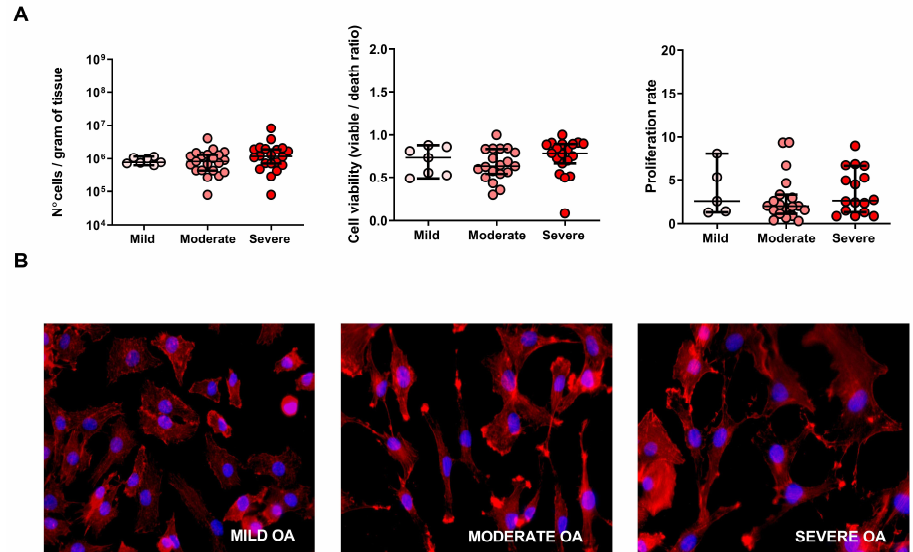
Figure 3. Cell number, viability and proliferation rate of cells derived from mild, moderate and severe OA regions. ( A ) The number of cells obtained from different OA grades after tissue digestion ( left panel). The ratio of live/death cells after the isolation from the different OA grades ( middle panel). The ratio between cell number obtained after the isolation from tissue and after the 2 weeks of in vitro proliferation (D14) ( right panel). ( B ) Immunofluorescence of F-actin by phaloidine to visualize the morphology of cells derived from mild, moderate and sever OA. A non-parametric Kruskal–Wallis and Mann–Whitney test.